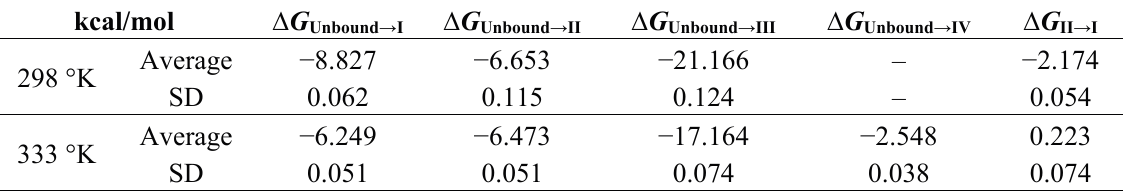
Table 2. Free energy differences between the unbound and complexation states.